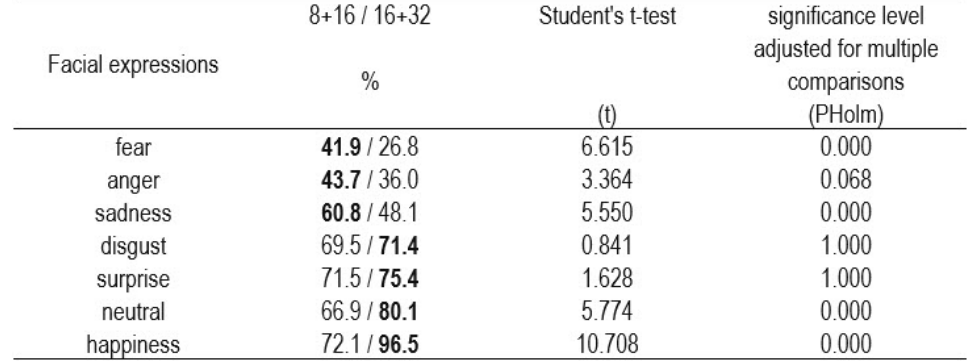
Comparison of recognition accuracy of different expressions for stimuli with a bandwidth of 2 octaves